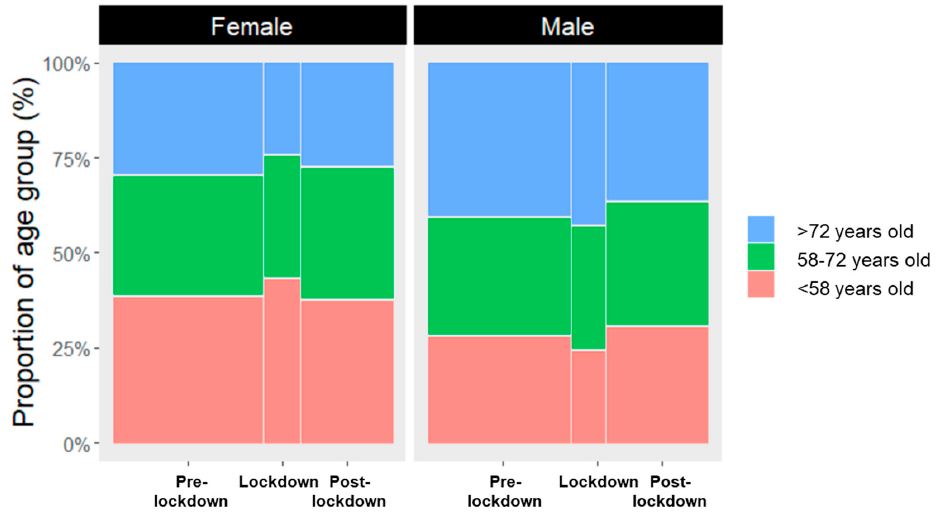
Figure 5. Age- and gender-dependent distribution of diagnosed melanomas relative to COVID-19 period in Switzerland. The proportion of diagnoses did not change before, during and after the COVID-lockdown period. Age groups are defined as young (<58 years), average (58–72 years) and old (>72 years).